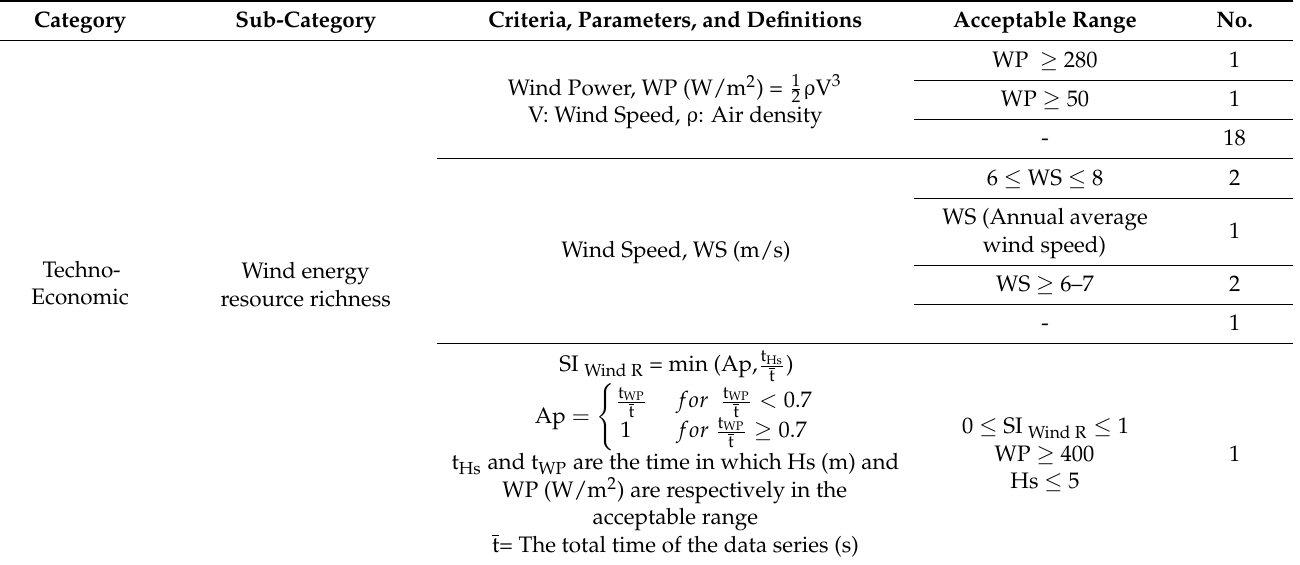
Table A1. Details of criteria, including definitions, formulae, and acceptable range. Category Sub-Category Criteria, Parameters, and Definitions Acceptable Range